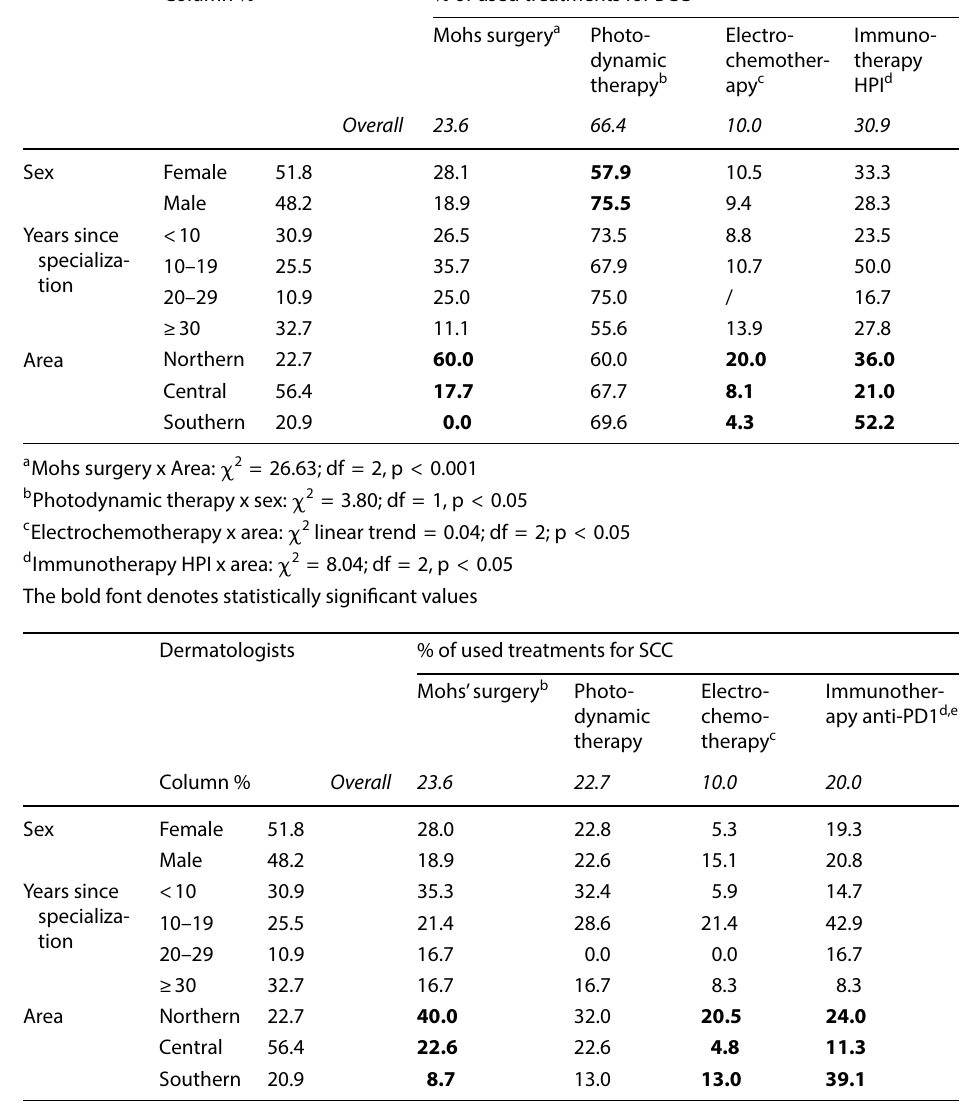
Table 1 Description of the sample and relationship between sociodemographic features and therapeutic choices for BCC (N = 110)